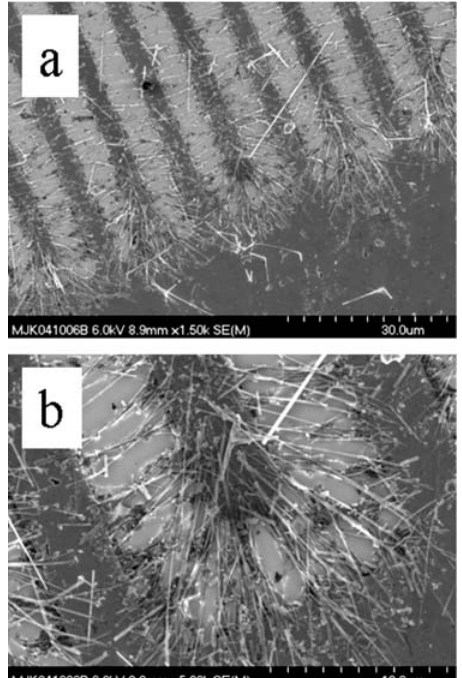
Figure 16. SEM image illustrating concentrated collection of TiO dielectrophoresis, acting preferentially in the region of highest E-field